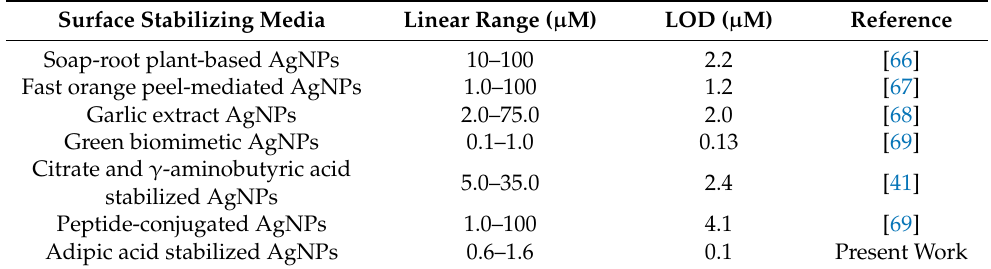
Table 2. Comparison of AgNPs stabilized by different methods as a colorimetric sensing probe for Hg 2+